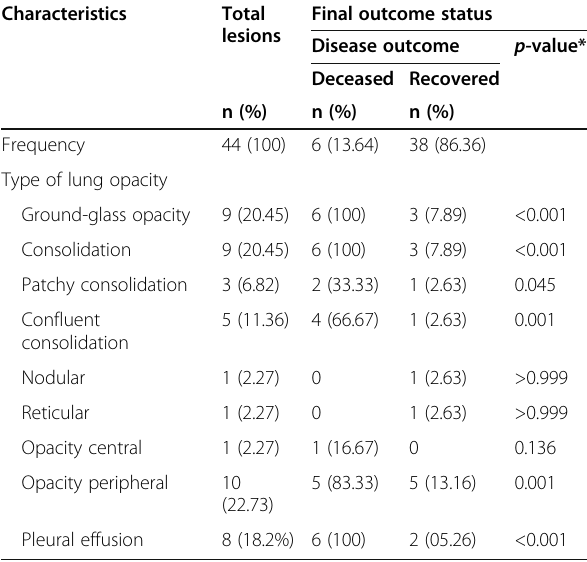
Table 3 Chest radiographic findings and disease progression of MERS-Cov cases by final outcome